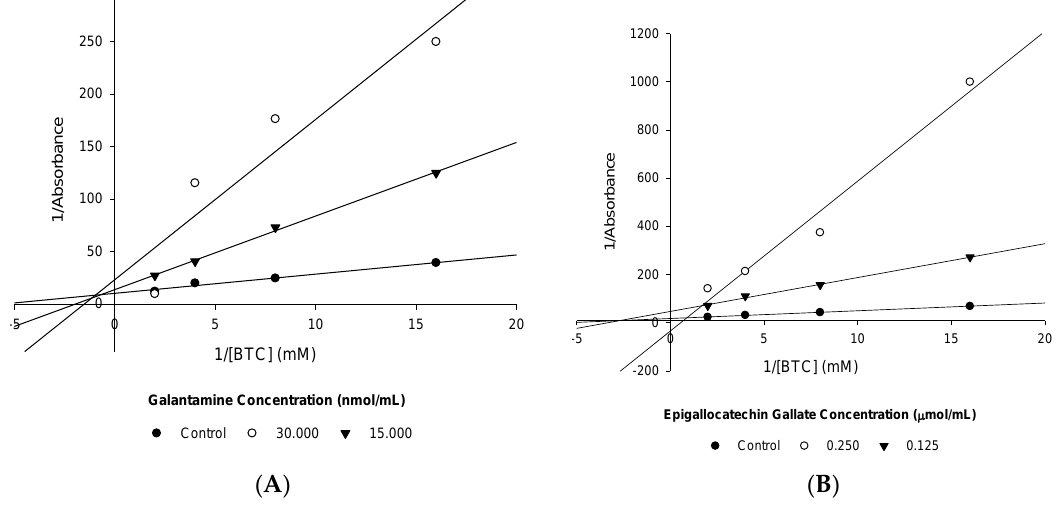
Figure 4. L-B plots of BuChE inhibition. ( A ) Gal and ( B ) EGCG.